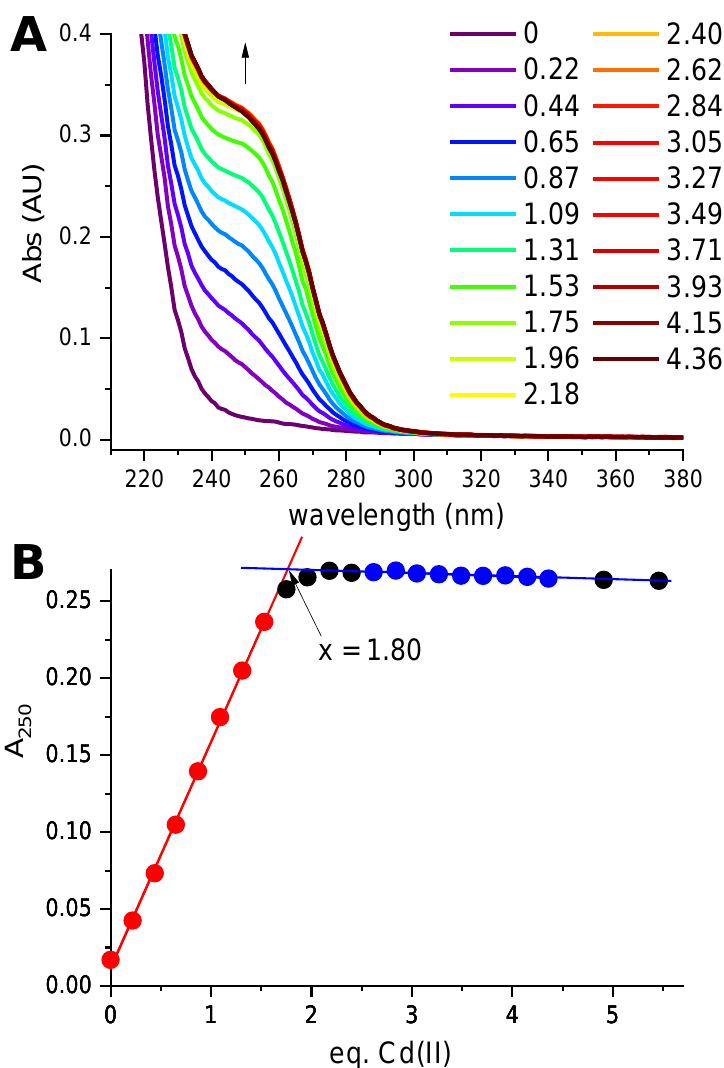
Figure 1. Titration of 12.57 µ M hepcidin-25 with CdCl 2 in the presence of 0.5 mM tris(2-carboxyethyl)phosphine (TCEP) at pH 5.0. ( A ). The spectra featuring the CT band at 250 nm formed upon the increasing Cd(II)/hepcidin-25 ratios (color coded in the plot); the arrow marks the direction of changes; ( B ). The titration curve at 250 nm. The red and blue segments of the curve were used to define the straight lines of the binding-site saturation. Their crossing at 1.80 Cd(II) equivalents determines the saturation concentration.